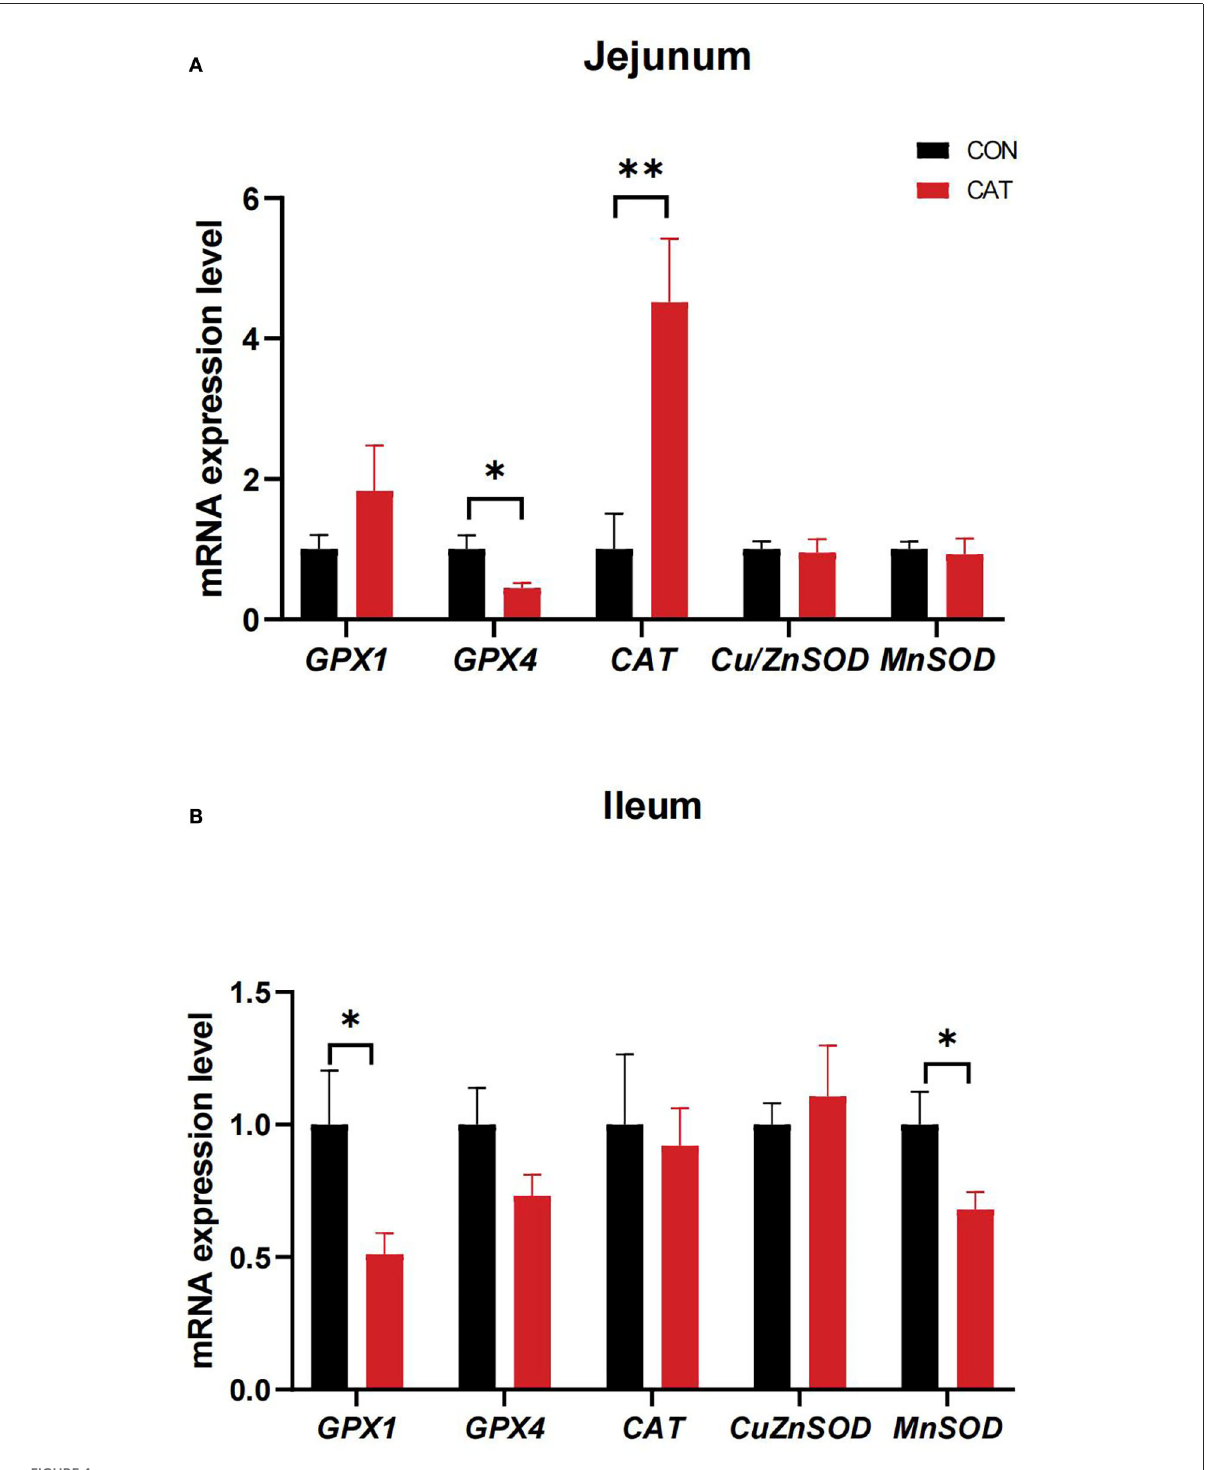
FIGURE4 (A,B) The mRNA expression of genes related to intestinal antioxidant enzymes of suckling piglets. Values are presented as mean ± SEM; n = 6, * and ** indicate a significant difference at P < 0.05 and P < 0.01, respectively. GPX1, glutathione peroxidase 1; GPX4, glutathione peroxidase 4; CAT, catalase; Cu/ZnSOD, superoxide dismutase [Cu/Zn]; MnSOD, superoxide dismutase